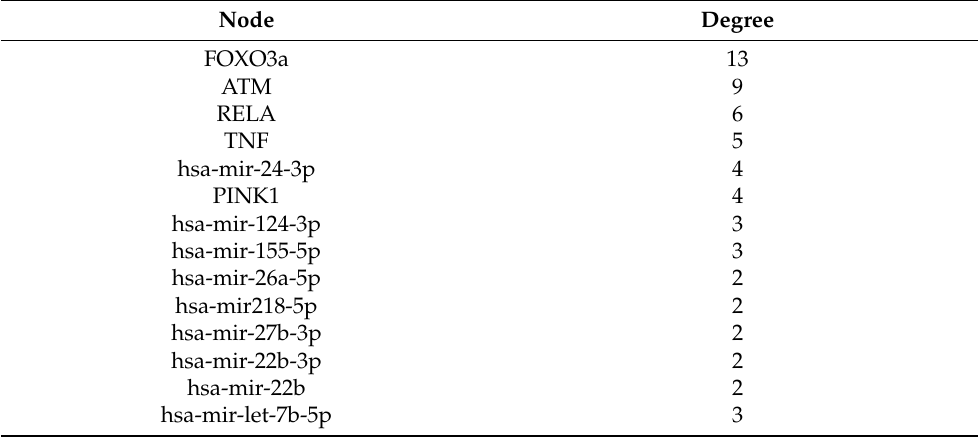
Table 2. Top miRNAs and targeted mRNAs in the network interactions determined via miRNet. Node